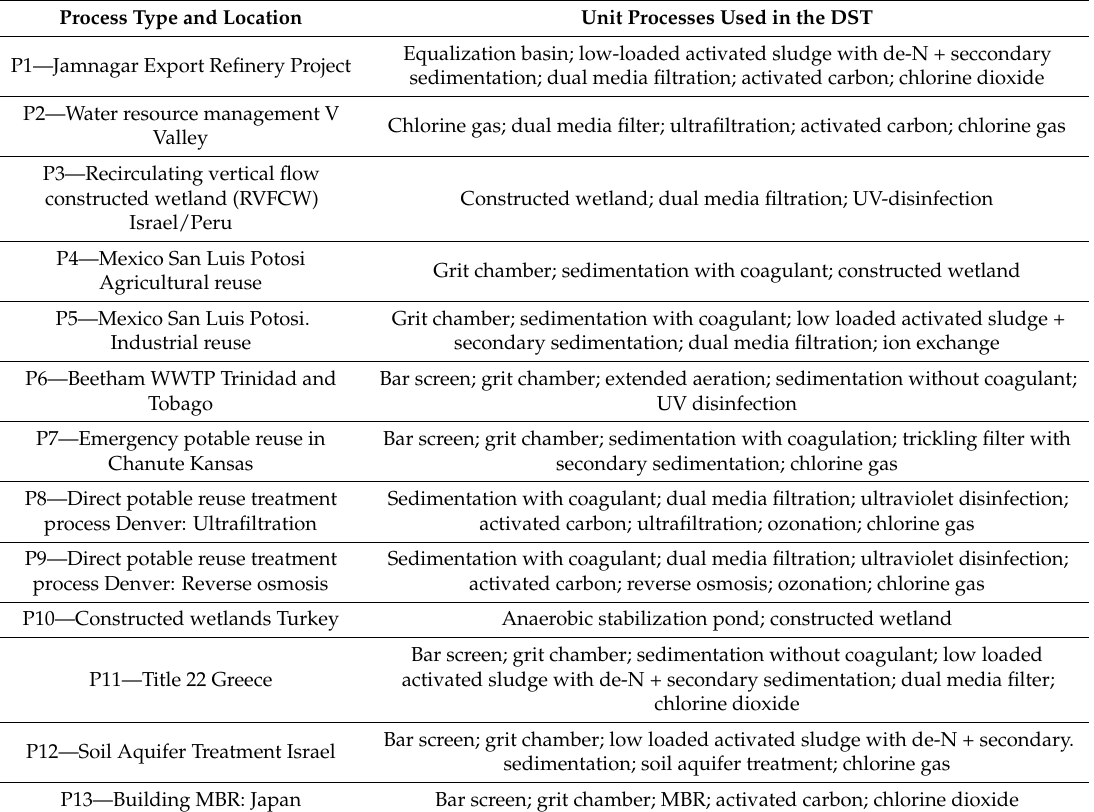
Table 10. Treatment trains considered for the plausibility checks ([29,35]).